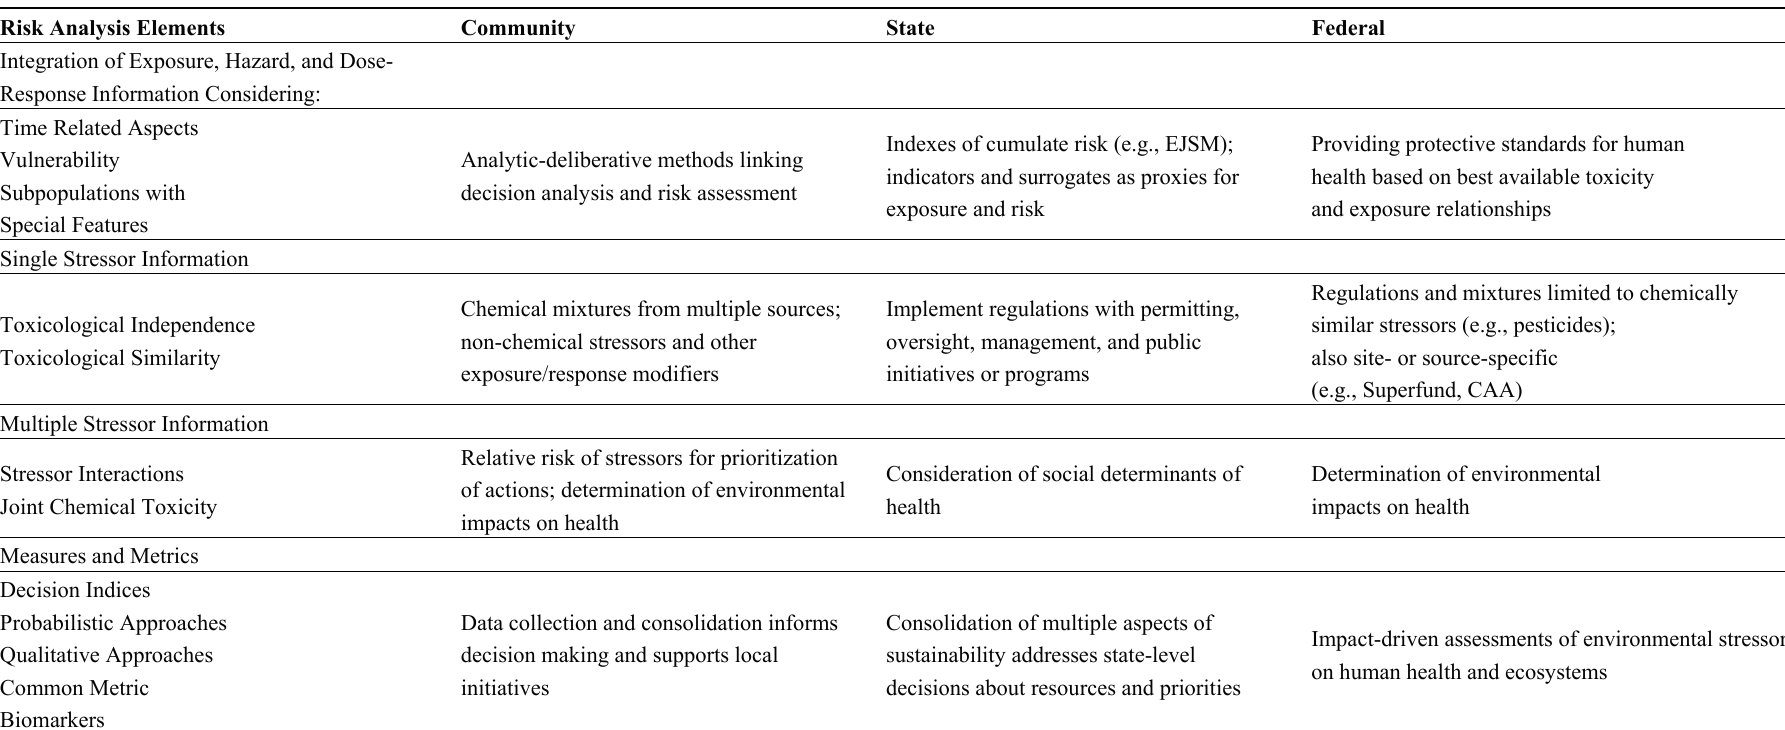
Table 3. Synopsis of Risk Analysis elements for Phase 2 of a CRA for Community, State, and Federal